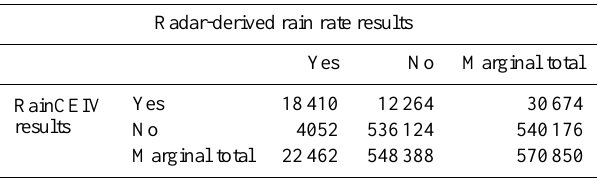
Table 11. Dichotomous statistical scores (RainCEIV versus radar- derived rain rate measurements) for the case studies listed in Table 8. The statistical scores are shown for all rainy classes ( C 1 , C 2 ) , light to moderate rain (C 1 ) , and heavy to very heavy rain (C 2 )